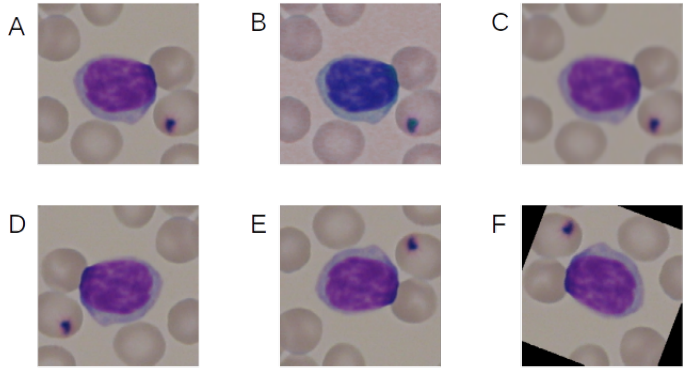
Figure 4. Example of the effect of the augmentation techniques used. ( A ) No augmentation, ( B ) color jitter, ( C ) Gaussian blur, ( D ) horizontal flip, ( E ) vertical flip, and ( F ) rotation.